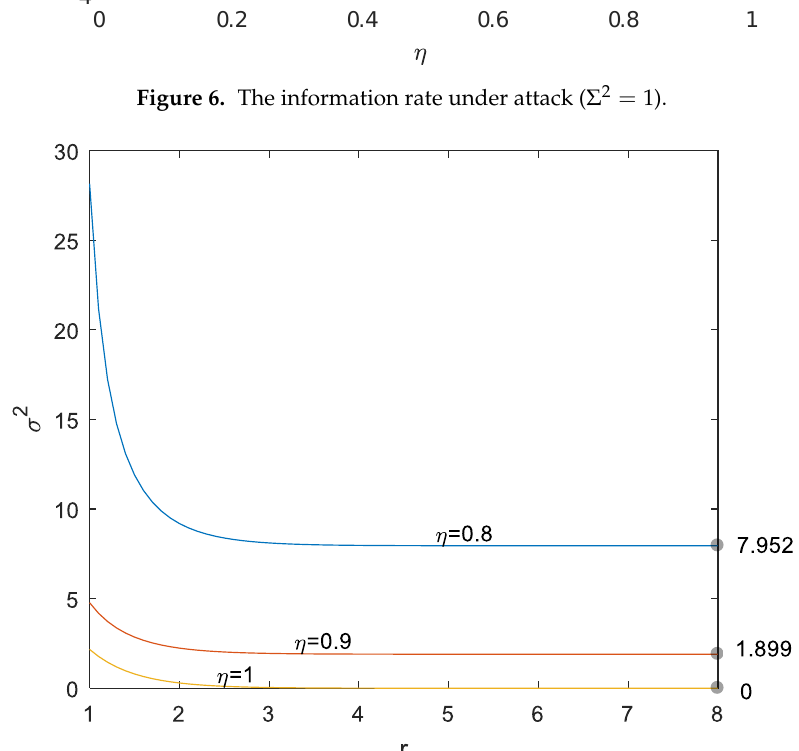
Figure 7. The relation between the squeezed parameter r and the variance of message σ 2 , when ∆ I = log 3 2